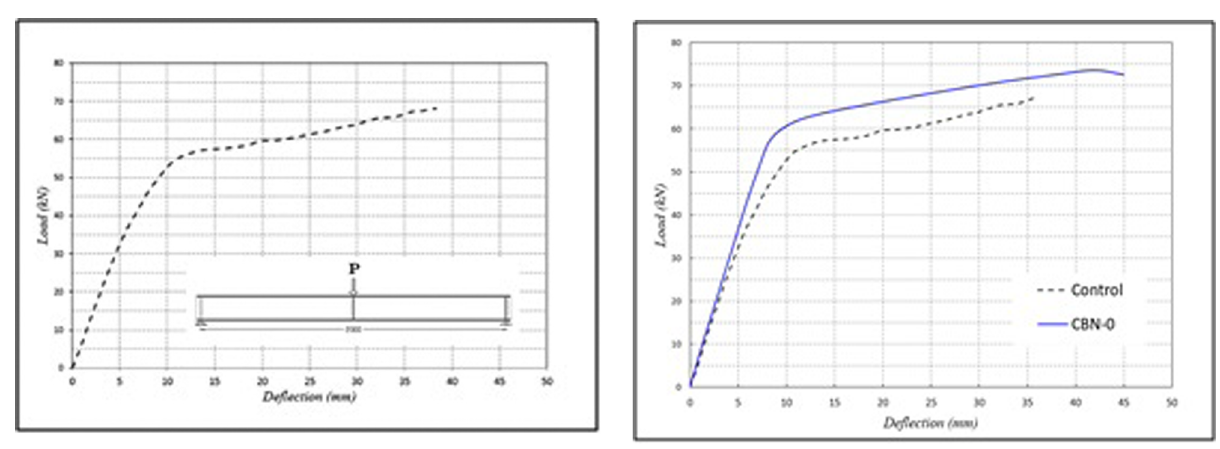
Figure 11: Load – de fl ection curves of CBN - 0 and control specimen.